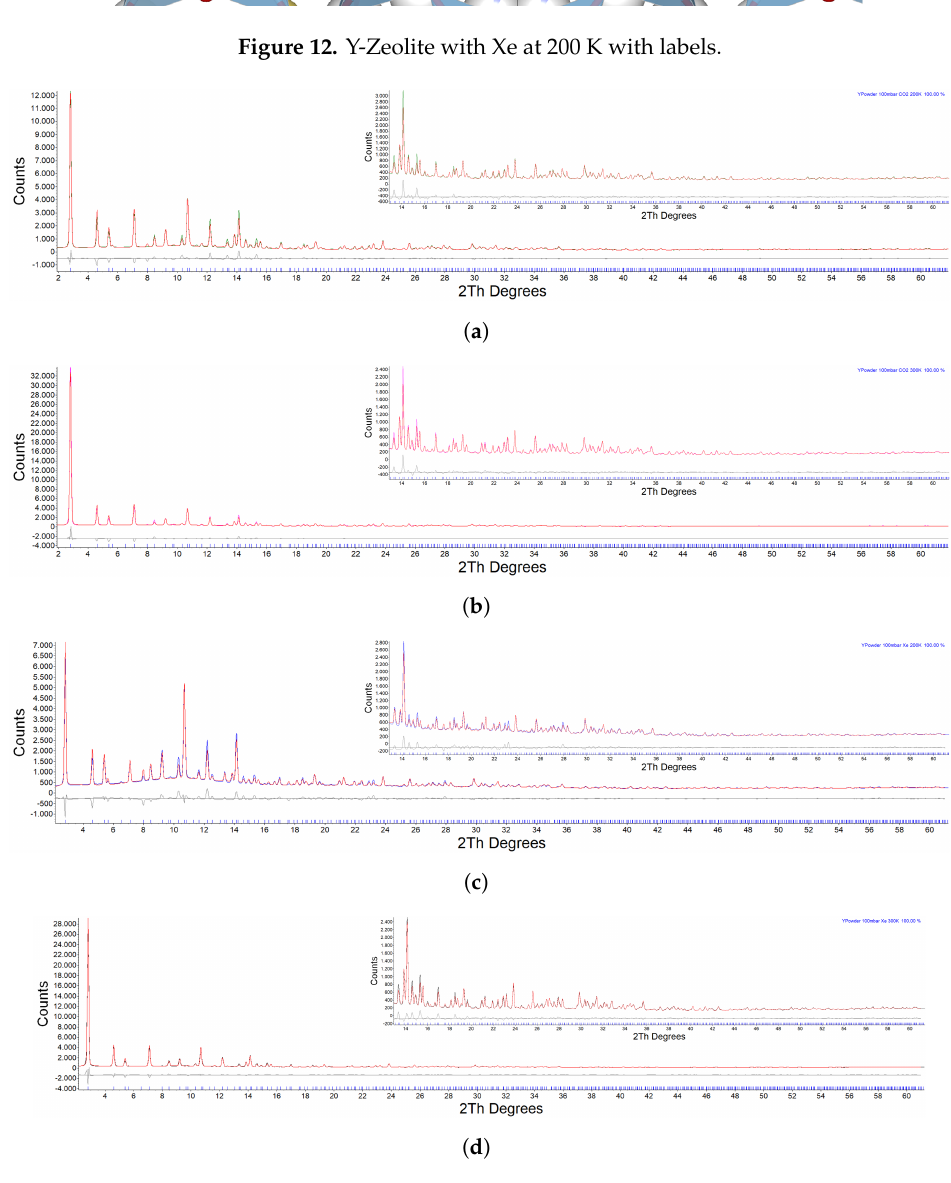
Figure 13. Rietveld refinement of XRPD pattern at 200 K and 300 K for CO 2 ( a , b ) and Xe ( c , d ). ( a ) 200 K CO 2 ; ( b ) 300 K CO 2 ; ( c ) 200 K Xe; ( d ) 300 K Xe.